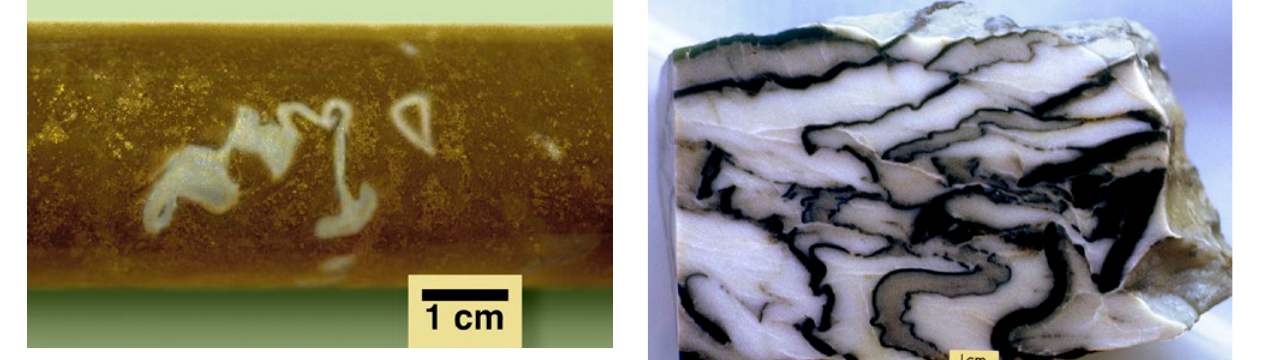
Figure 34. Highly fluid or “poured in” vein quartz or a disjoin- ted plastically contorted fragment of vein quartz occurs in a large mineralised lode intersection. This core is from Woodlawn Mine, NSW, and a number of almost ptygmatic quartz veins and frag- ments of veins of this type were intersected in this